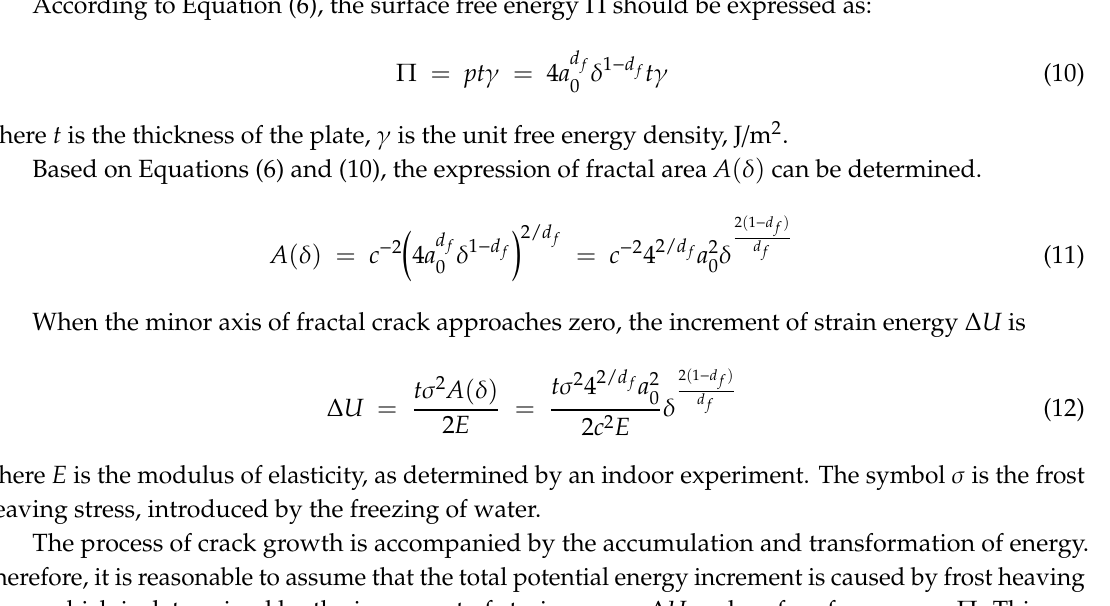
21 A ; the correlation coefficients f d p 1 and